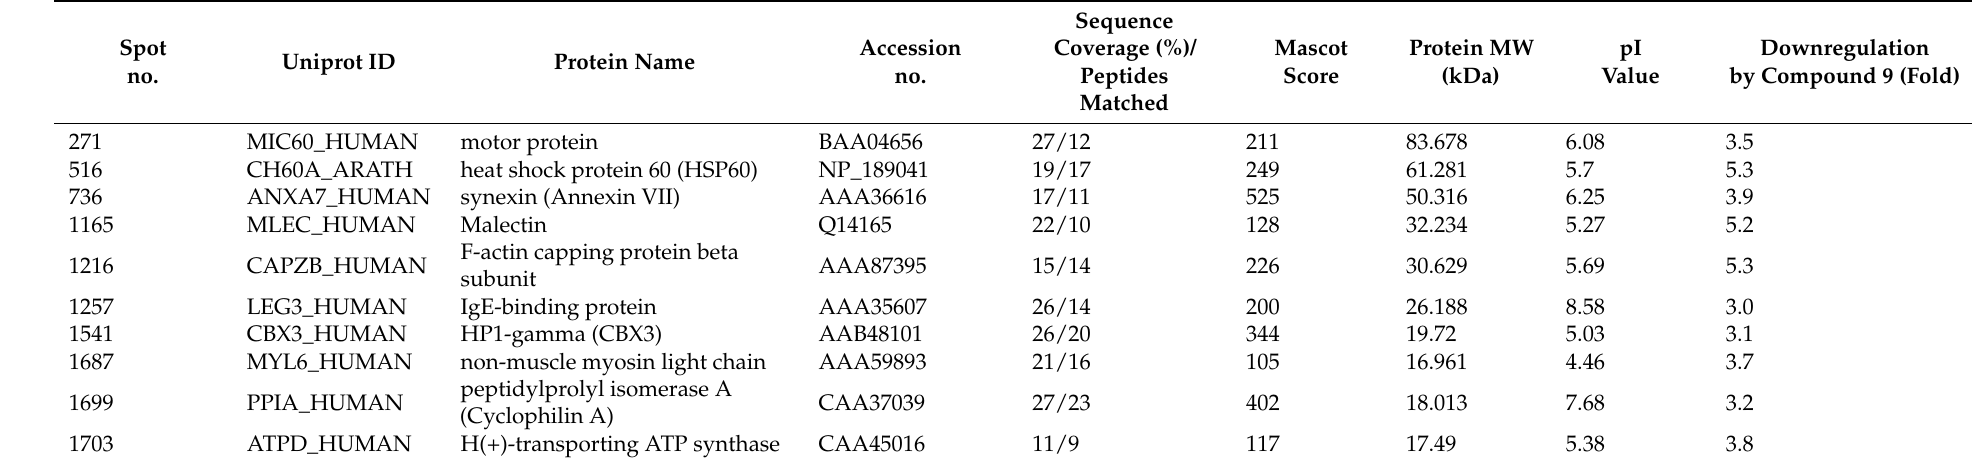
Table 1. Ten protein spots identified by MALDI-TOF